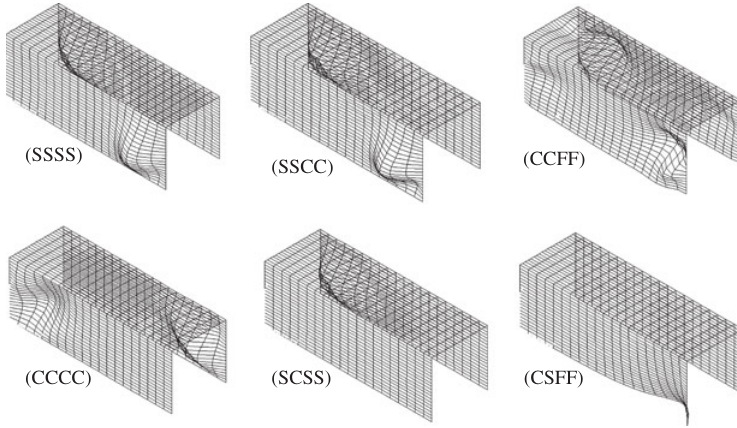
Figure 10 Thermal buckling modes for different boundary conditions of two-fold laminated